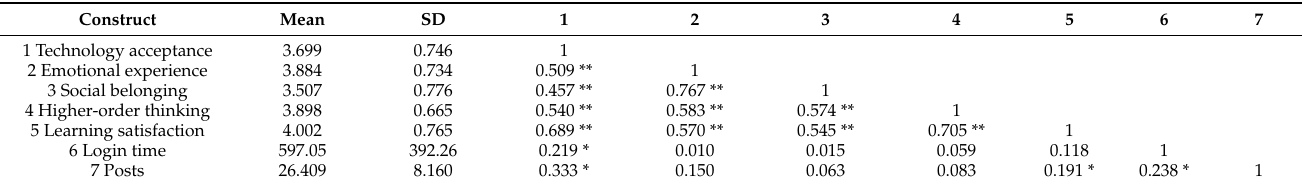
Table 3. Descriptive statistics and Pearson correlations.